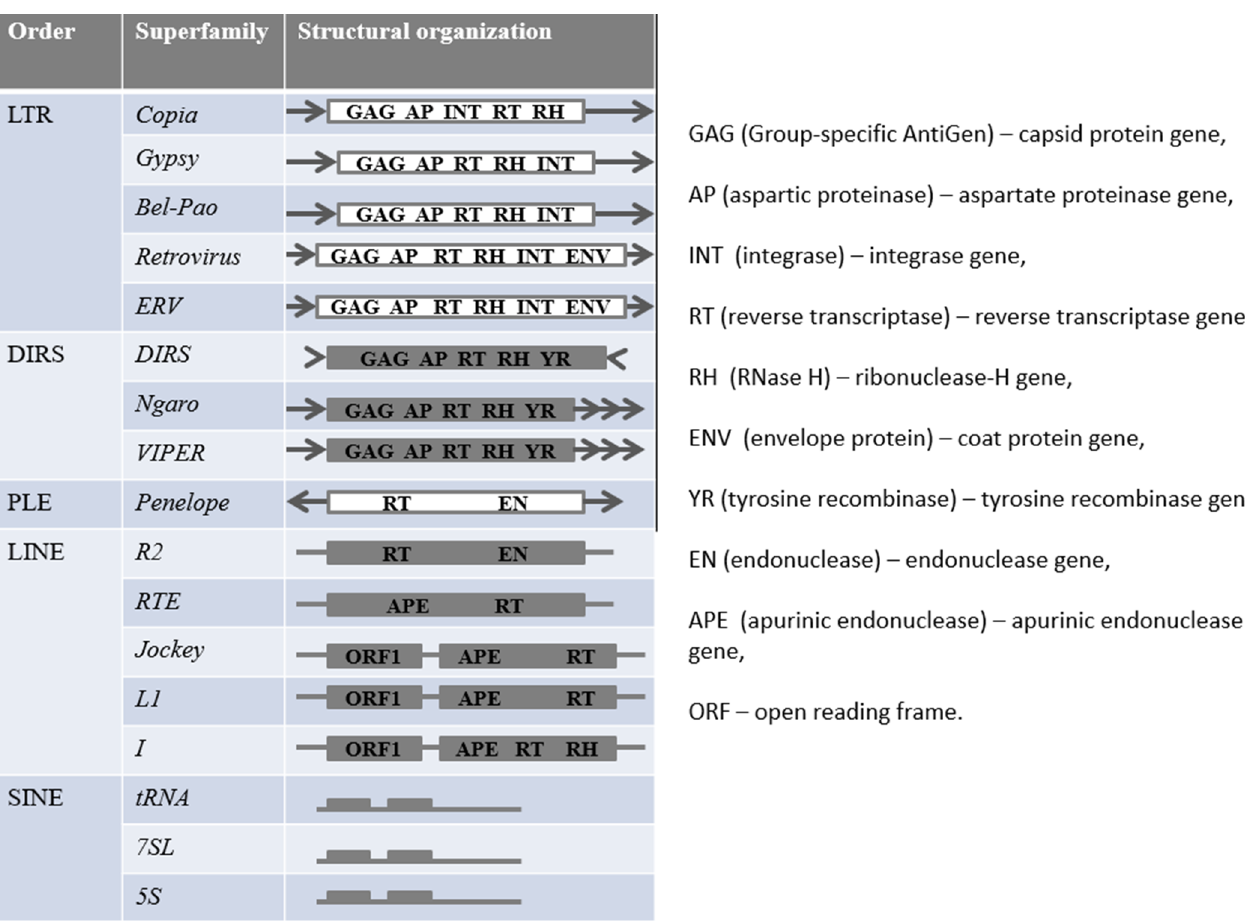
Figure 1. Classi fi cation of retroelements. Figure 1. Classification of